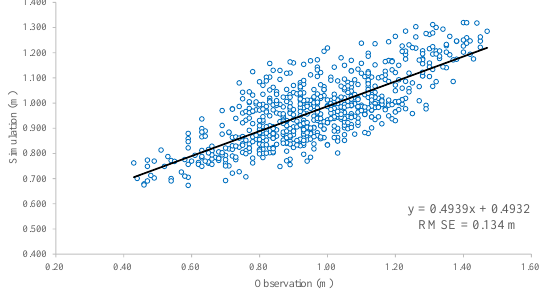
Figure 3. Scatterplot and RMS error of simulated surface water level with tide gauge observation in June 2016